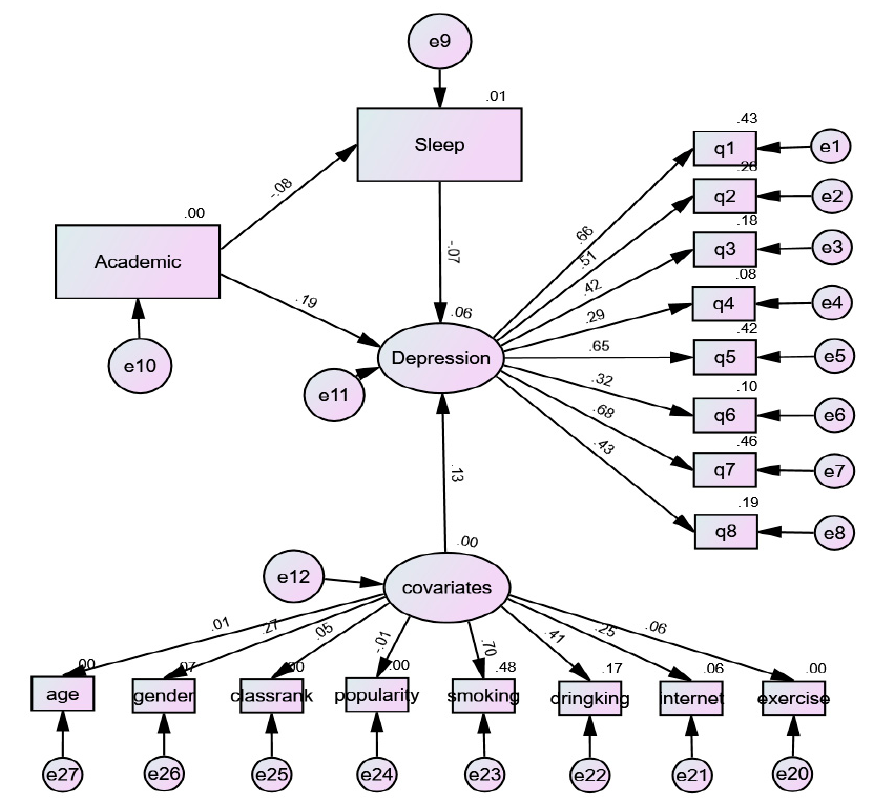
Figure 2. Results of the validated model.